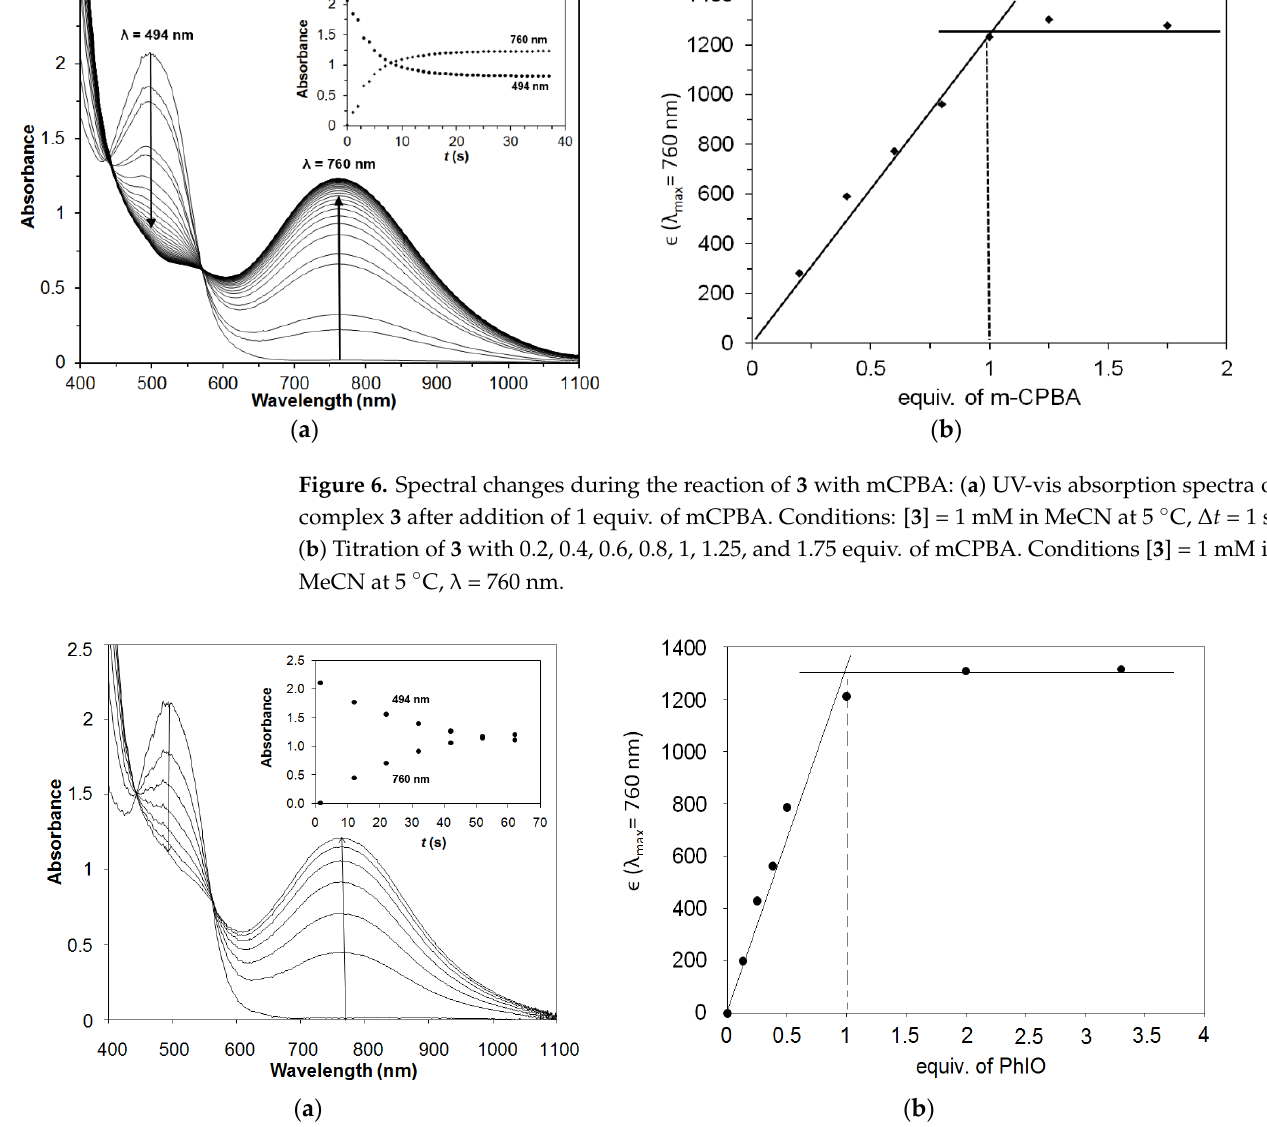
Figure 7. Spectral changes during the reaction of 3 with PhIO. ( a ) UV–Vis absorption spectra of complex 3 after addition of 1 equivivalent of PhIO. Conditions: [ 3 ] = 1 mM in MeCN at 5 °C, Δ t = 10 s.; ( b ) Titration of 3 with PhIO. Conditions [ 3 ] = 1 mM in MeCN at 5 °C, λ = 760 nm.